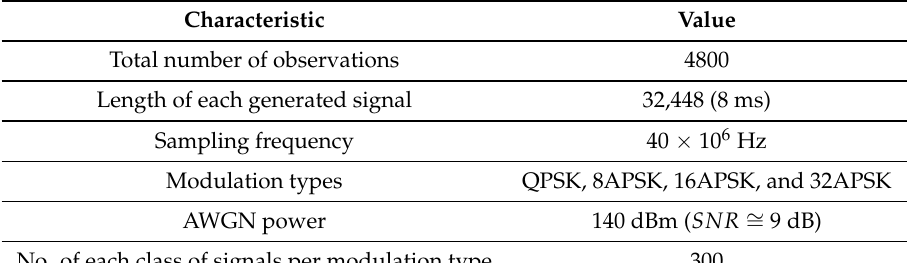
Table 1. Real-time dataset